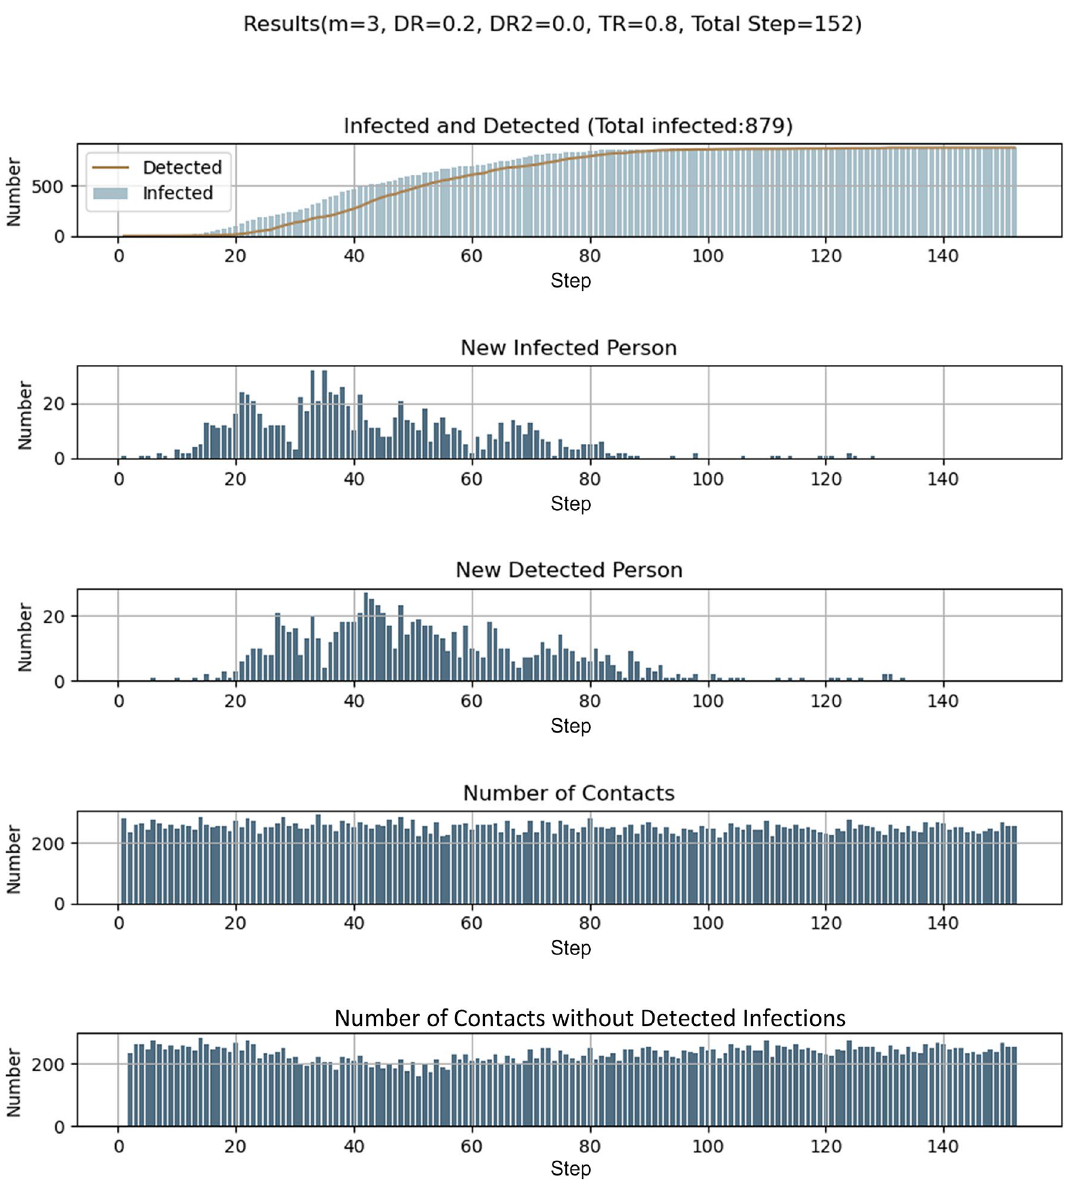
Figure 2. Example of time-dependent virus transmission. The parameters are as follows: N = 1000, M = 2000, t = 1. At the initial state, m max was set to 100 and is reduced to m max = 0 when the number of detected infections reaches 1% (10 people). Infected patients are infectious for 15 steps (five steps as non-detectable asymptotic persons and ten steps as a symptomatic and detectable patient). After fifteen steps, they are removed from the system: they cannot be infected nor become infectious a second time. Parameters are given in the